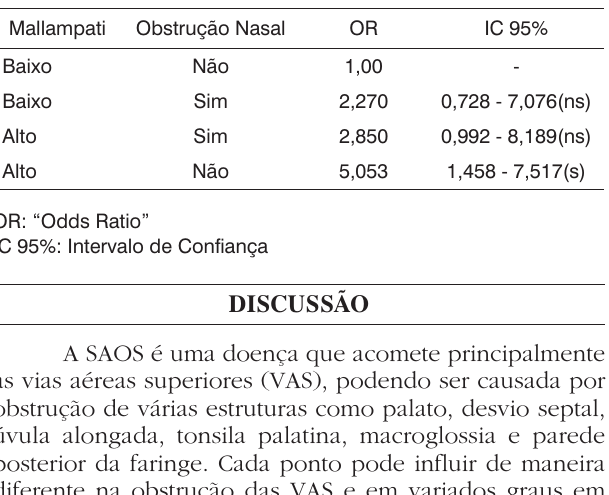
Obstrução Nasal com AIH> 15